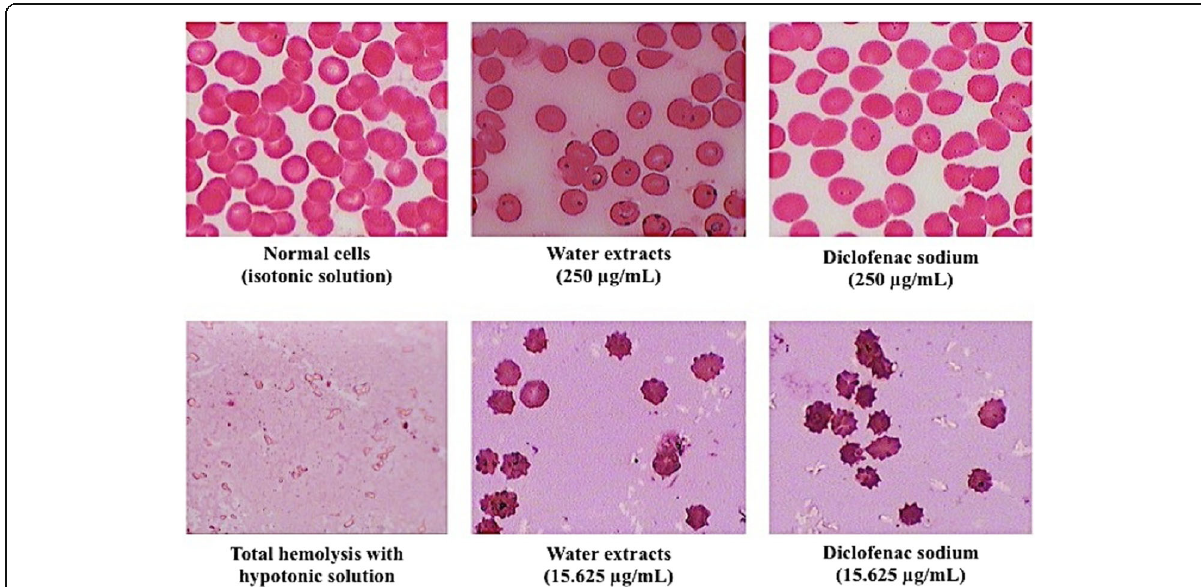
Fig. 4 Appearance of erythrocytes before and after the treatment with the extract and sodium diclofenac. The smear was performed before and after treatment with extracts and sodium diclofenac to observe the appearance of erythrocytes. Here it is the case of hemolysis induced by a hypotonic solution. It is well shown that at 250 μ g/mL of drugs, erythrocytes have a normal form. However at low concentration (15.625 μ g/mL), these cells have an irregular contour testifying to disorganization of the membrane but the cells are not